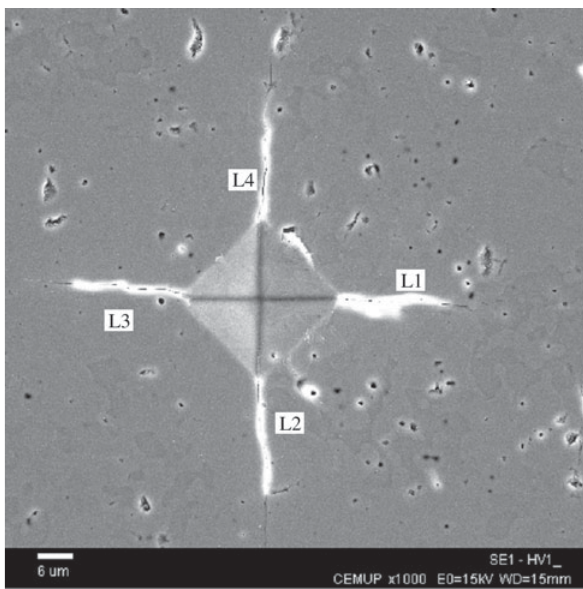
Figure 1. Vickers indentation showing the diagonals and crack length as measured for K determination. Ic